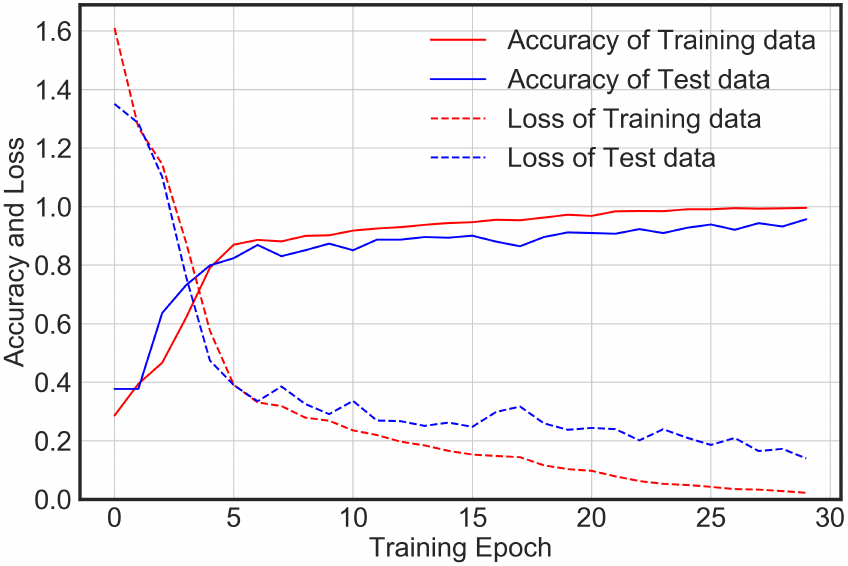
Figure 6. CNN model accuracy and loss for training and test